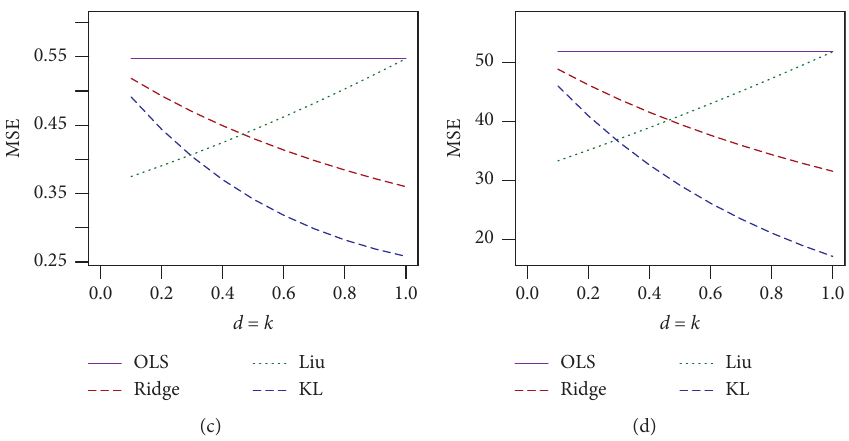
Figure 1: Estimated MSEs for n � 30. Sigma � 1, 10, rho � 0.70, 0.80 and different values of k � d . (a) n � 30, p � 3, sigma � 1, and rho � 0.70. (b) n � 30, p � 3, sigma � 10, and rho � 0.70. (c) n � 30, p � 3, sigma � 1, and rho � 0.80. (d) n � 30, p � 3, sigma � 10, and rho � 0.80.